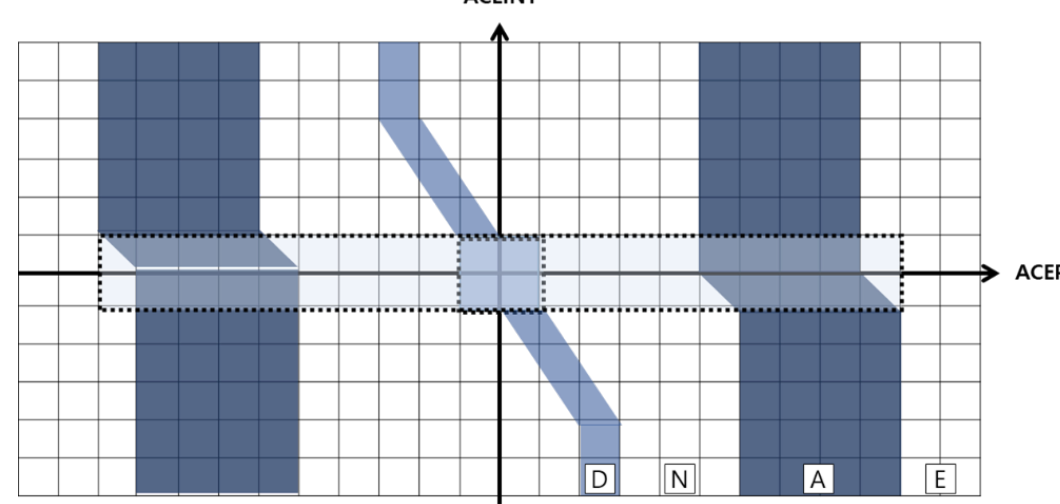
Figure 2. Concept of dynamic deadband in deadband filter.